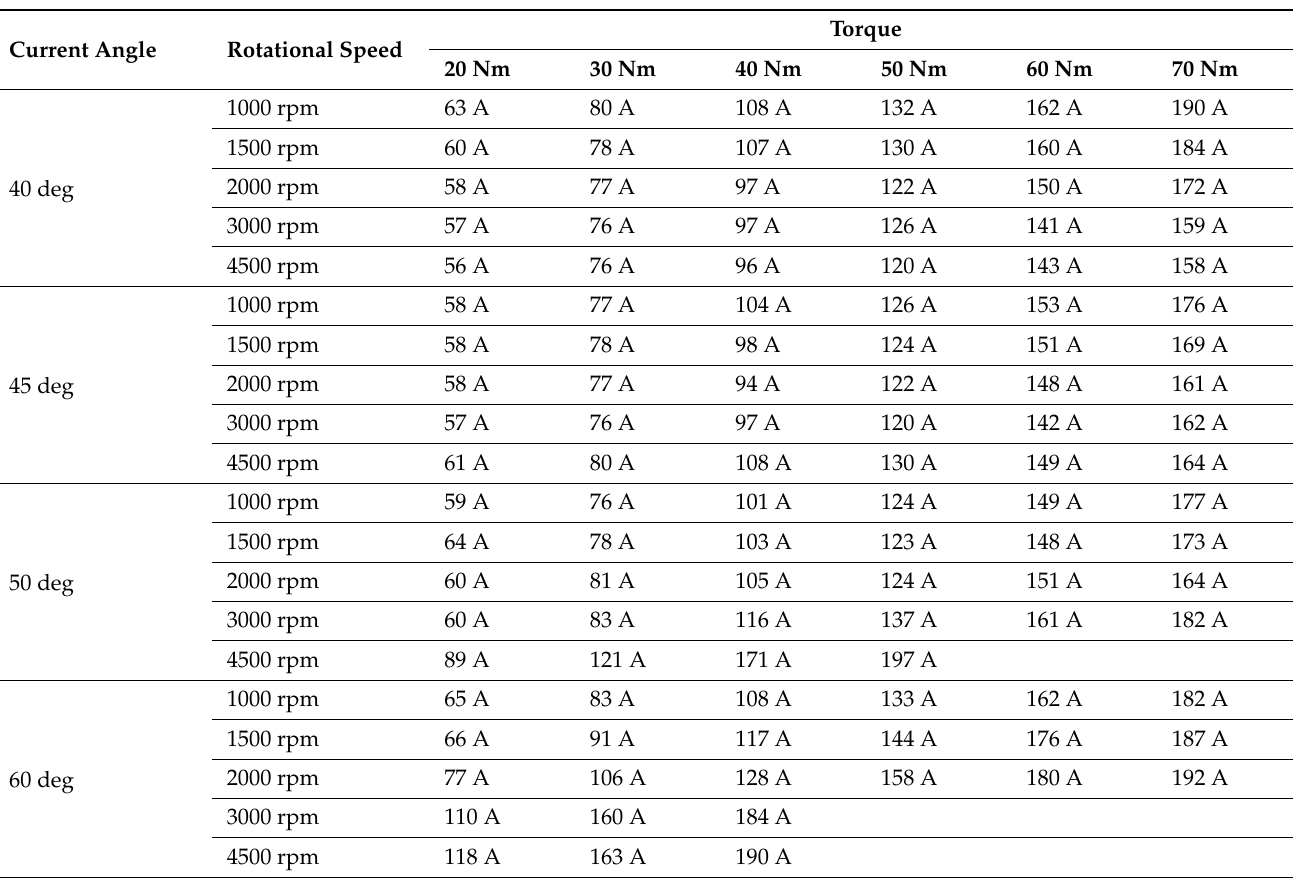
Table 5. Motor phase current RMS values for various load and current angles at different rotational speeds.